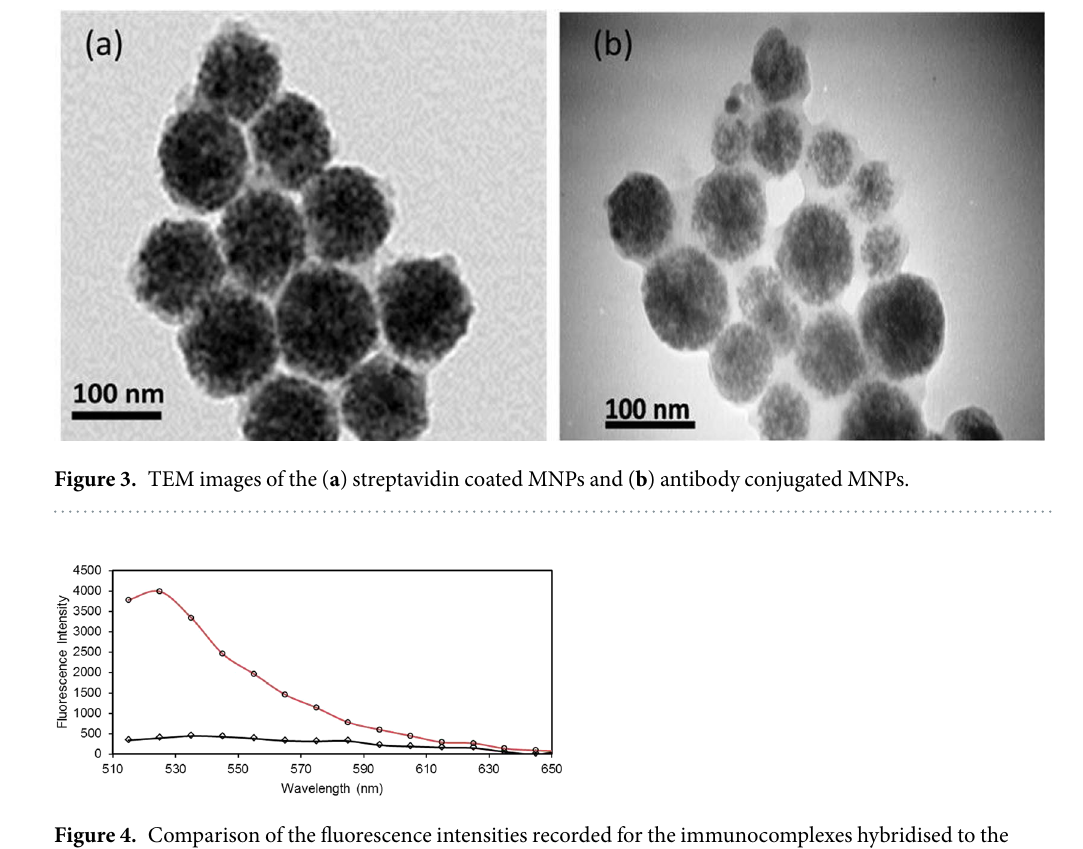
Figure 4. Comparison of the fluorescence intensities recorded for the immunocomplexes hybridised to the ssDNA probes immobilised on the streptavidin coated surface of the microtiter plate heterogeneously (rhombi) and that of the MNPs semi-homogenously